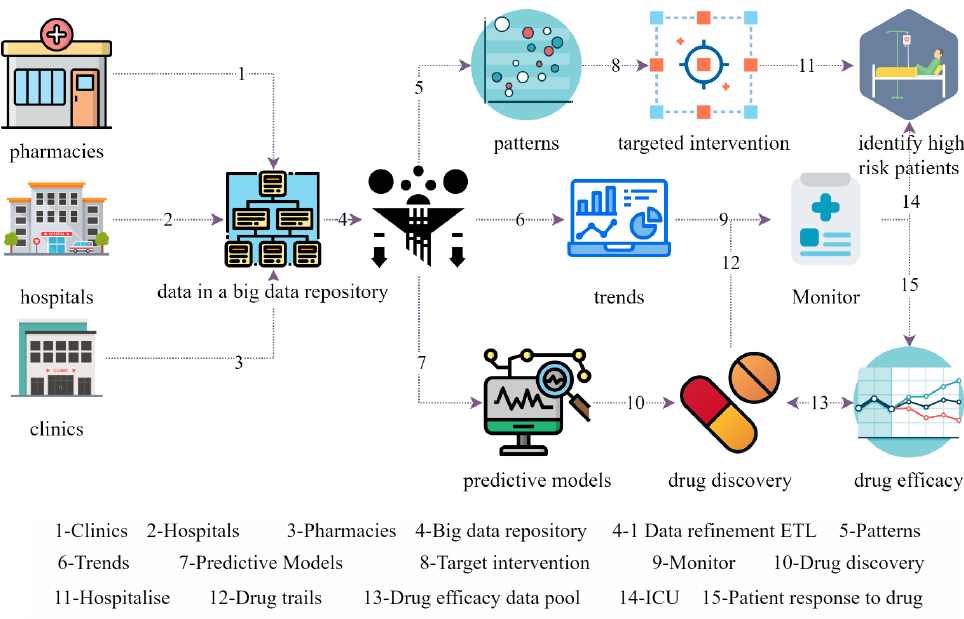
Figure 1. Generic representational workflow of big data in the Hospital and Pharmacology ecosystem.